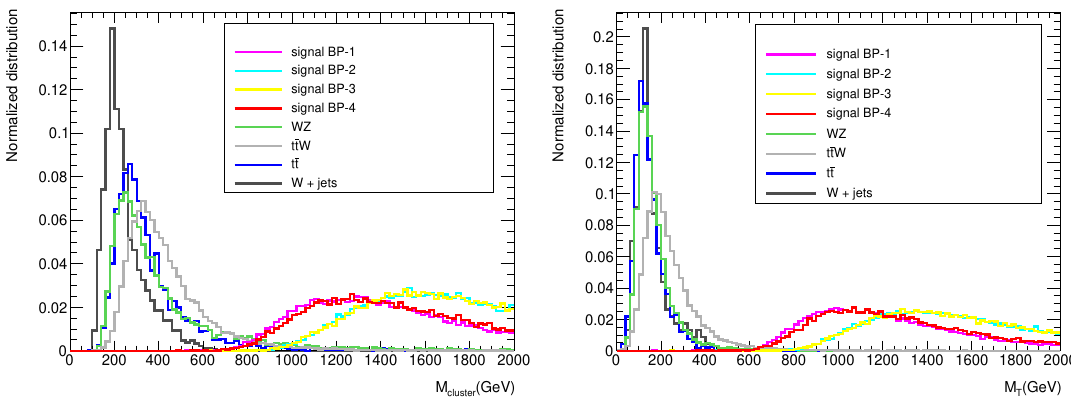
Figure 12 . Distribution of cluster transverse mass(left) and transverse mass(right) for the four signal BPs and backgrounds in case I.